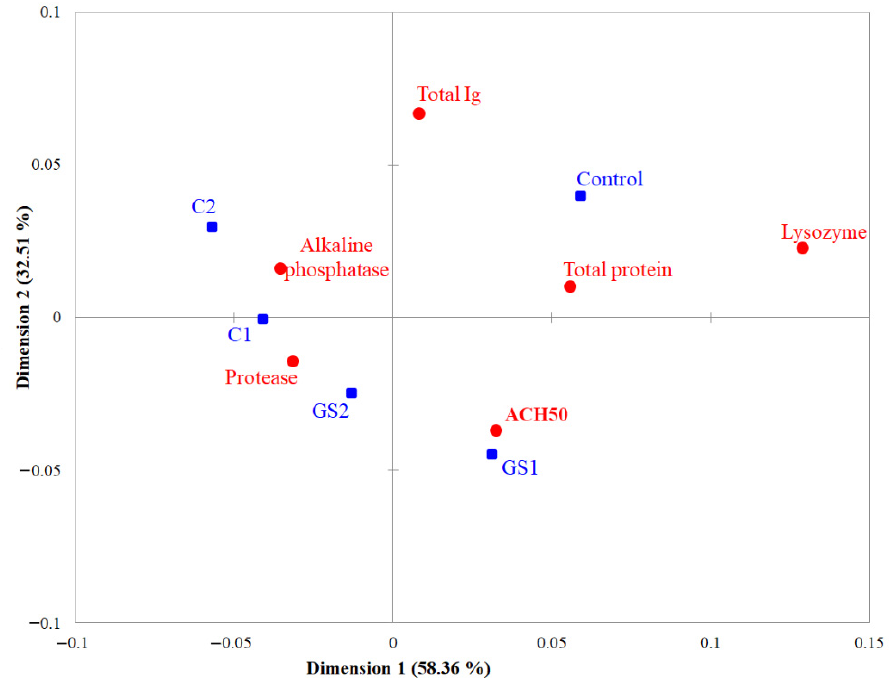
Figure 7. Correspondence analysis ordination plot and position of the five analyzed groups (control, GS1, GS2, C1, and C2) to the analyzed immune